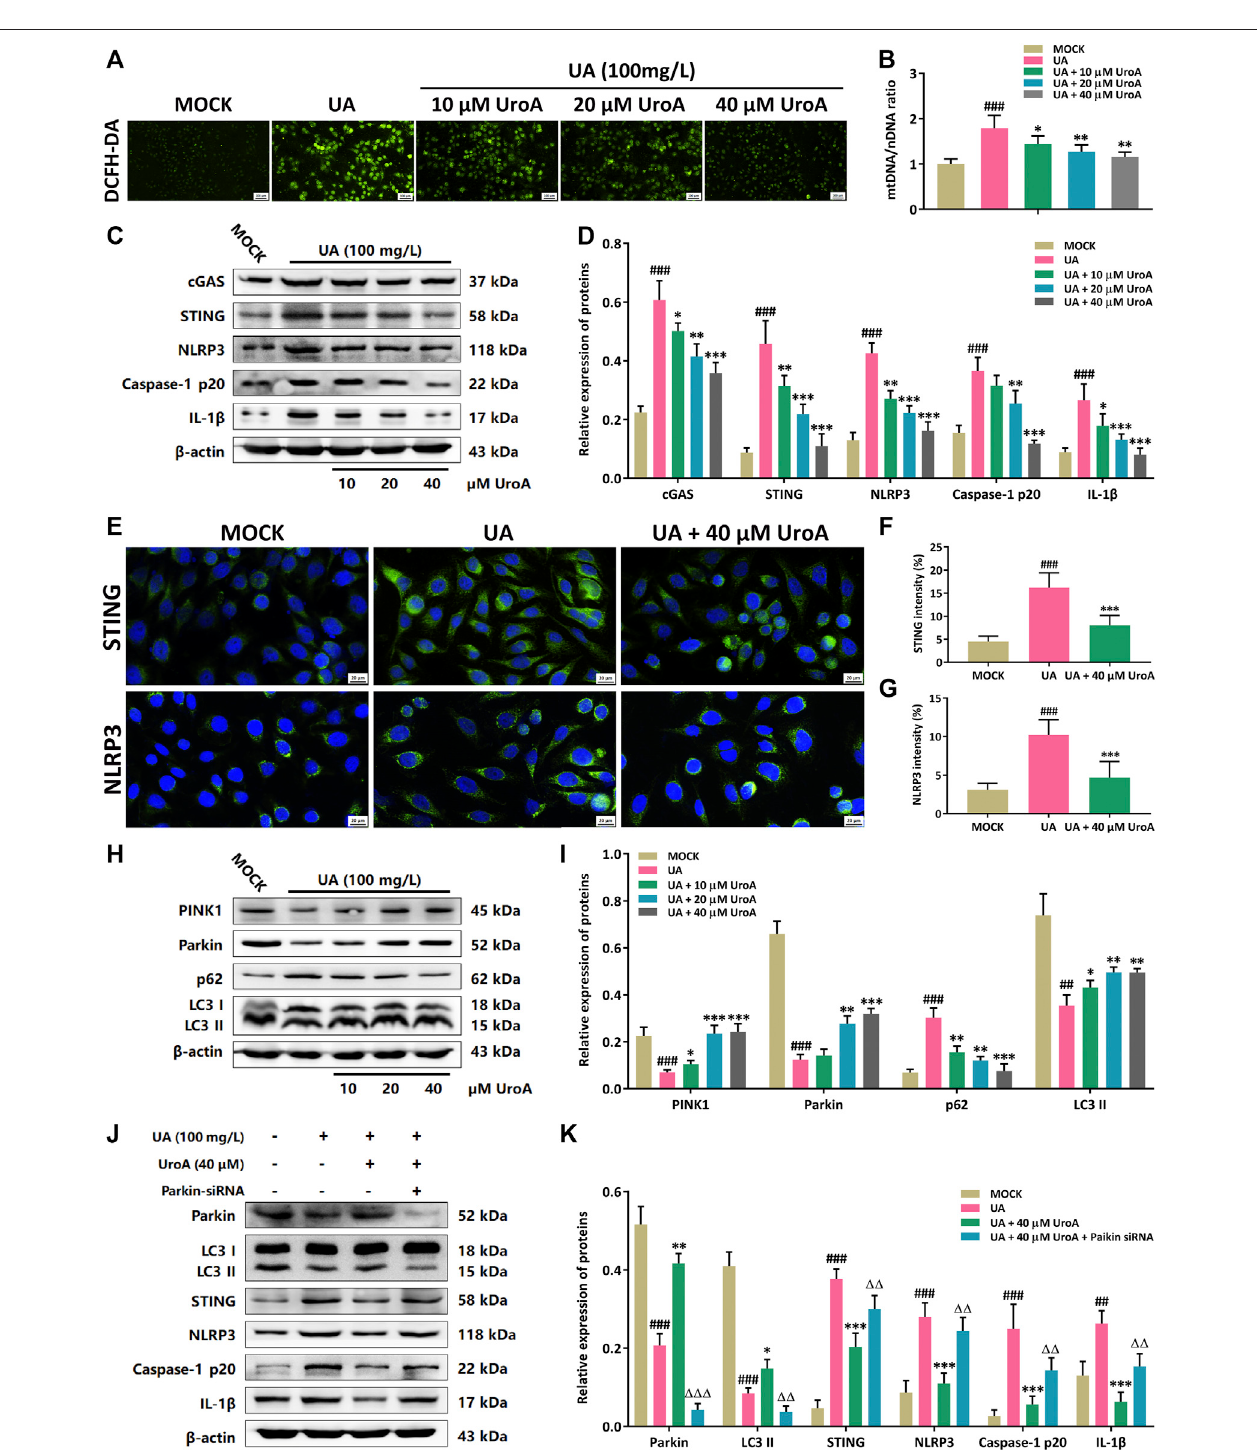
FIGURE 5 | Urolithin A (UroA) inhibits STING-NLRP3 activation by promoting Parkin-dependent mitophagy in vitro . (A) Representative immuno fl uorescence blots of ROS levels in the MOCK or uric acid (UA)-induced HK-2 cells with the administration of UroA (0 – 40 μ M), respectively. (B) Mitochondrial DNA (mtDNA) to nuclear DNA (nDNA) ratio in uric acid-induced HK-2 cells with the administration of UroA. (C,D) Representative immunoblots of cGAS, STING, NLRP3, Caspase-1 p20, and IL-1 β in HK-2 cells (C) and densitometric analysis (D) . (E – G) Representative blots of STING and NLRP3 immuno fl uorescence in HK-2 cells (E) and fl uorescence intensity analysis (F,G) . (H,I) Representative immunoblots of PINK1, Parkin, p62, and LC3 I/II protein levels in HK-2 cells (H) and densitometric analysis (I) . (J,K) Representative immunoblots of Parkin, LC3 I/II, STING, NLRP3, Caspase-1 p20, and IL-1 β in the uric acid (UA)-induced HK-2 cells after parkin silencing (J) and densitometric analysis (K) . β -actin was used as an internal reference. Mean ± S.D., n = 5. ## p < 0.01, ### p < 0.001 versus the MOCK group; * p < 0.05, ** p < 0.01, *** p < 0.001 versus the UA treated group; △△ p < 0.01, △△△ p < 0.001 versus the UA and UroA co-processing group.